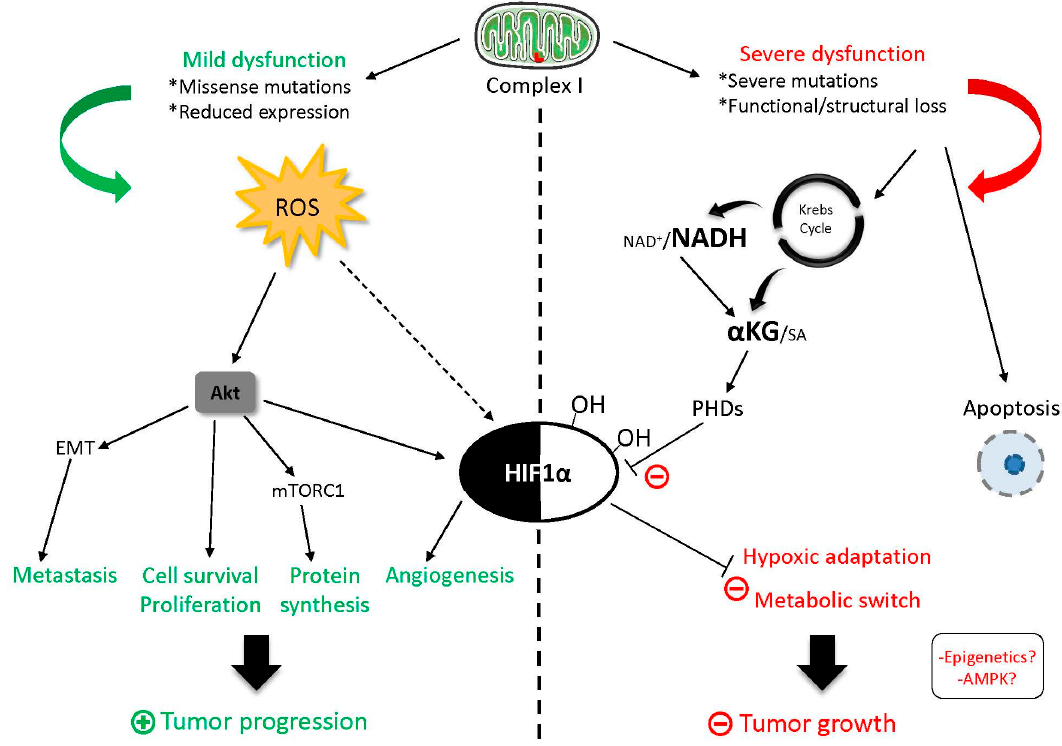
Figure 4. The oncojanus effect of CI encoding genes on tumorigenesis. Mild functional alterations of CI cause mitochondrial ROS overproduction and subsequent activation of the oncogenic Akt/mTORC1 (mammalian Target Of Rapamycin Complex 1) pathway that leads to cell proliferation and survival, epithelial–mesenchymal transition (EMT), and HIF1 α stabilization, thus favoring tumor progression. Conversely, severe CI dysfunction provokes the accumulation of tricarboxylic acids (TCA) cycle products NADH and α -ketoglutarate (KG), which impedes Hypoxia Inducible Factor (HIF) 1 α stabilization, hypoxic adaptation, ultimately arresting tumor growth. Moreover, the energetic crisis stimulates apoptotic cell